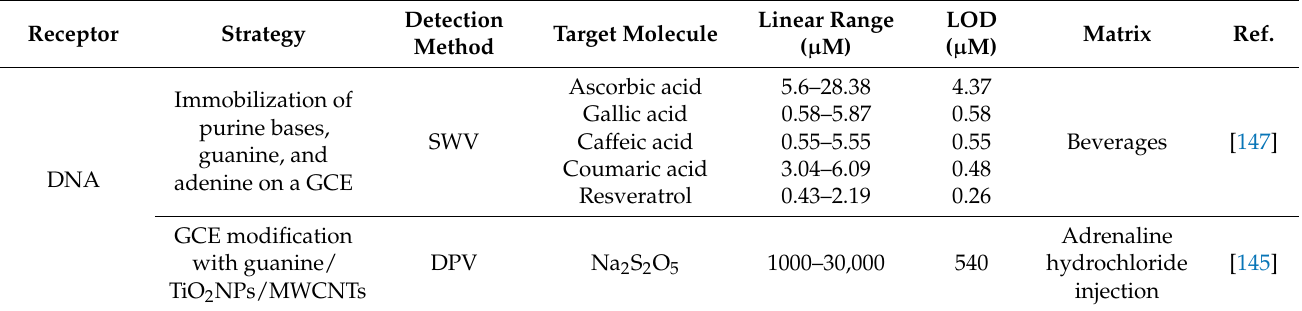
Table 3. Several examples of DNA-based biosensors for the determination of antioxidants in food